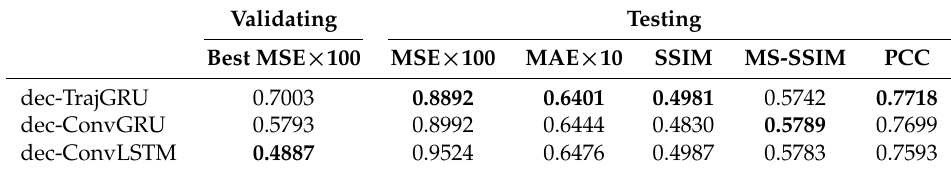
Table 2. Performances of three dec-seq2seq models. The presentation is similar to Table 1.